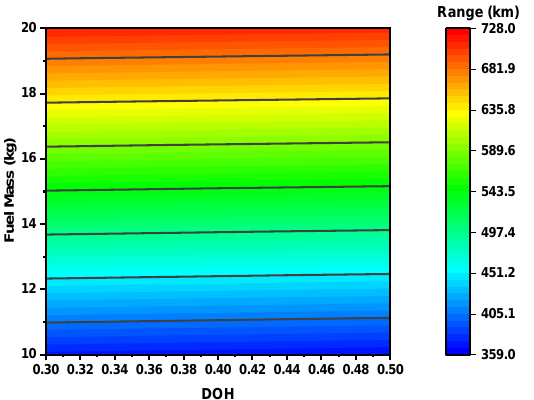
Figure 8. Hybrid electric fuel mass vs. DOH range comparison (ICE-only cruise).